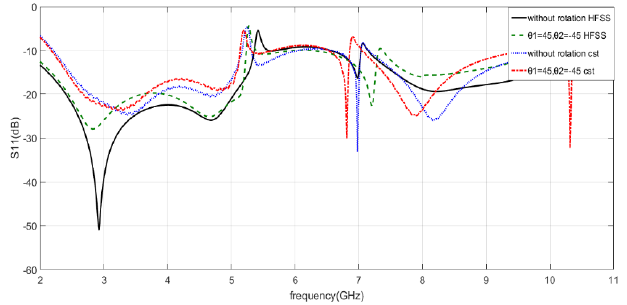
characteristics of 11